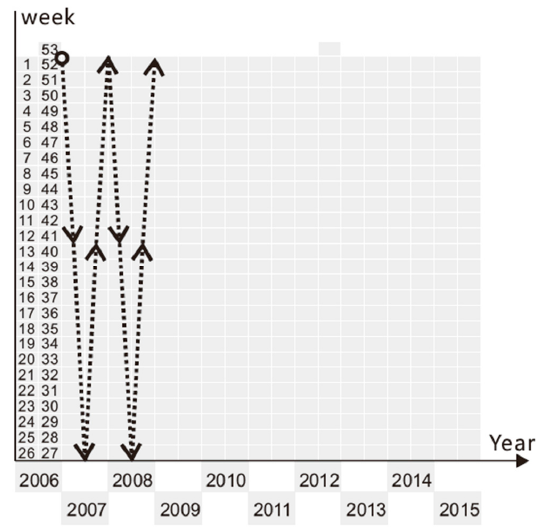
Figure 2. Cyclic structure of the calendar view at weekly precision.